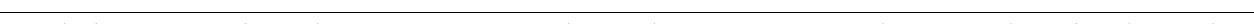
Fig. 4 Role of Nup42, RNA, and IP 6 in Dbp5/DDX19 activation. a Steady-state colorimetric ATPase assay with S. cerevisiae Dbp5 performed at 30 and 37 ° C with either puri fi ed S. cerevisiae Gle1 CTD or Gle1 CTD (cid:129) Nup42 GBM . Reactions were performed with 0.5 μ M Dbp5, 1.0 μ M Gle1 CTD or Gle1 CTD (cid:129) Nup42 GBM , 0.1 mg/ml polyA RNA, and 2.0 μ M IP 6 . Values shown are the average of three experiments. Error bars indicate the standard deviation. See also Supplementary Fig. 13. b Steady-state colorimetric ATPase assay with H. sapiens DDX19 performed at 30 and 37 °C with either puri fi ed H. sapiens Gle1 CTD or Gle1 CTD (cid:129) Nup42 GBM . Reactions were performed with 2.5 μ M DDX19, 5.0 μ M Gle1 CTD or Gle1 CTD (cid:129) Nup42 GBM , 0.1 mg/ml polyA RNA, and 10.0 μ M IP 6 . Values shown are the average of three experiments. Error bars indicate the standard deviation. See also Supplementary Fig. 13. c RNA dependence of S . cerevisiae Dbp5 activation using the same conditions as in a , but with the indicated amounts of RNA performed at 30 and 37 °C. d RNA dependence of H. sapiens DDX19 activation using the same conditions as in b , but with the indicated amounts of RNA performed at 30 and 37 °C. e IP 6 dependence of (left) S . cerevisiae Dbp5 or (right) H . sapiens DDX19 activation using the same conditions as in a or b , respectively, but with the indicated amounts of IP